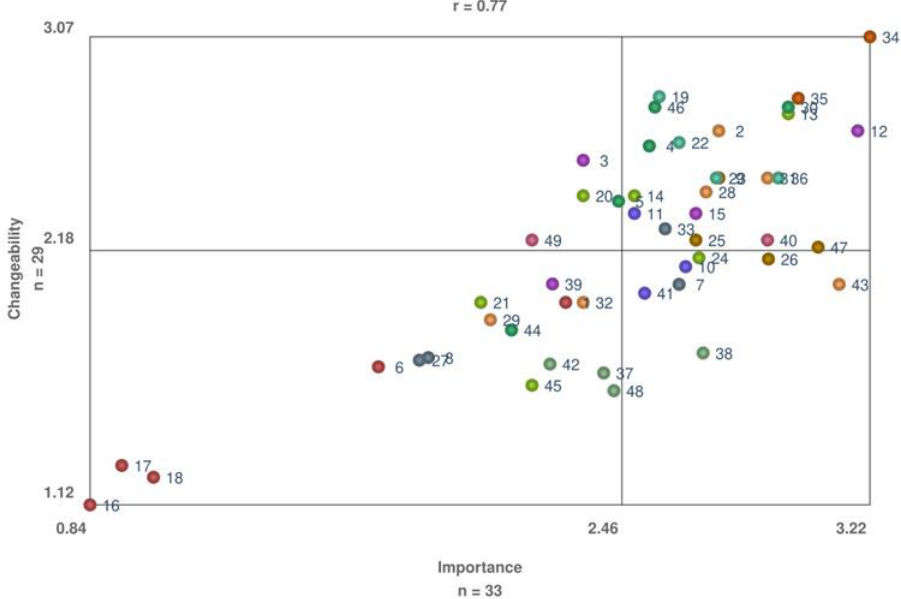
Figure 5. Go-zone display importance vs. changeability (i.e., it is possible to act on these factors to promote the adoption of MR-HIFU). Pearson’s correlation coefficient (r) = promote the adoption of MR- HIFU). Pearson’s correlation coefficient (r) = 0.77.